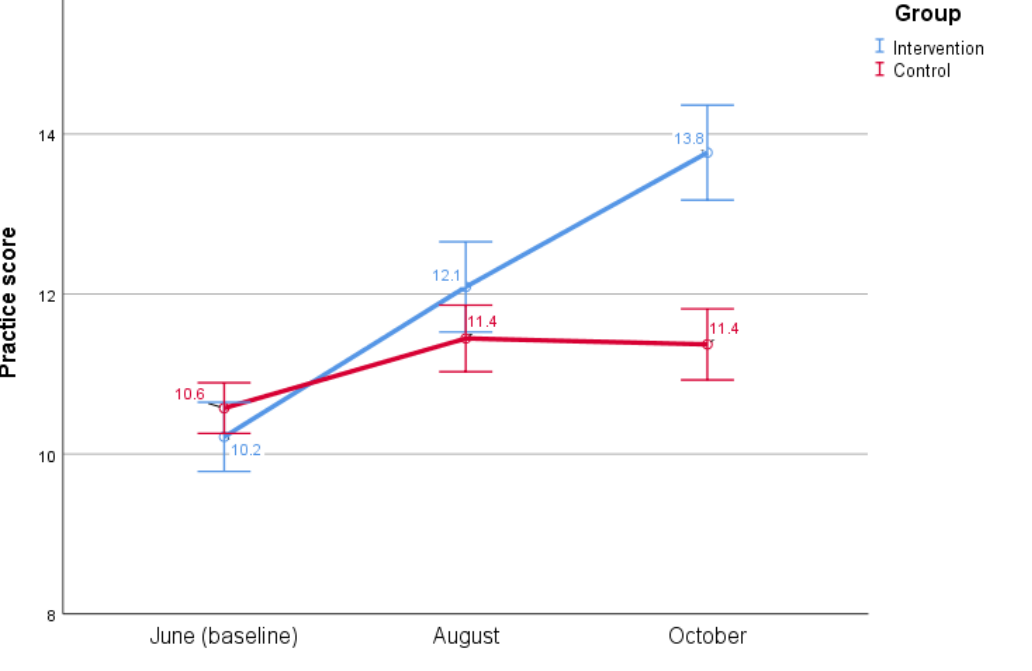
Figure 3. Change in mean dengue practice scores during three different times in 2020 in two low- income communities in Islamabad. Maximum practice score was 24.